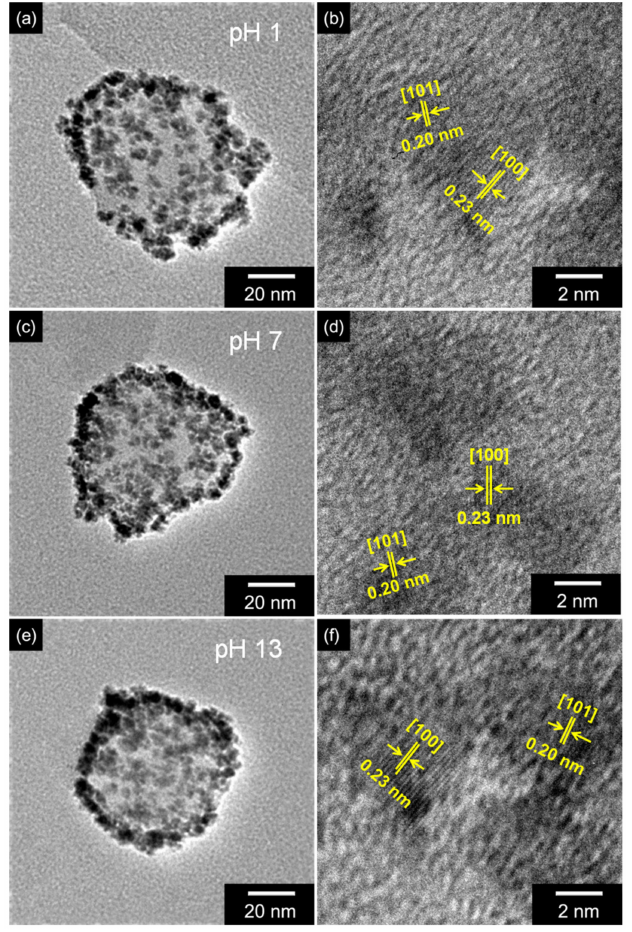
Figure 3. TEM and high-resolution transmission electron microscopy (HR-TEM) images of Ru_CPPy with di ff erent pH values: ( a , b ) pH 1; ( c , d ) pH 7; ( e , f ) pH